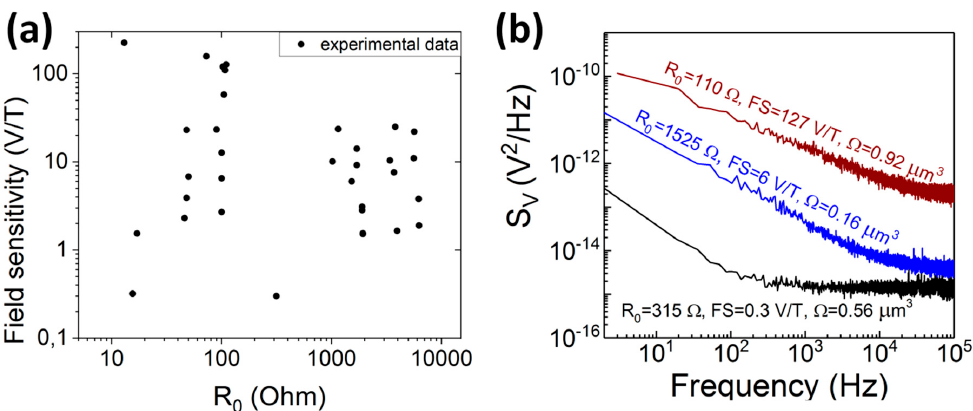
Figure 3. Resistance and field sensitivity of TMR sensors ( a ). Noise characteristics of selected sensors with different resistance, volume and field sensitivity values ( b ).